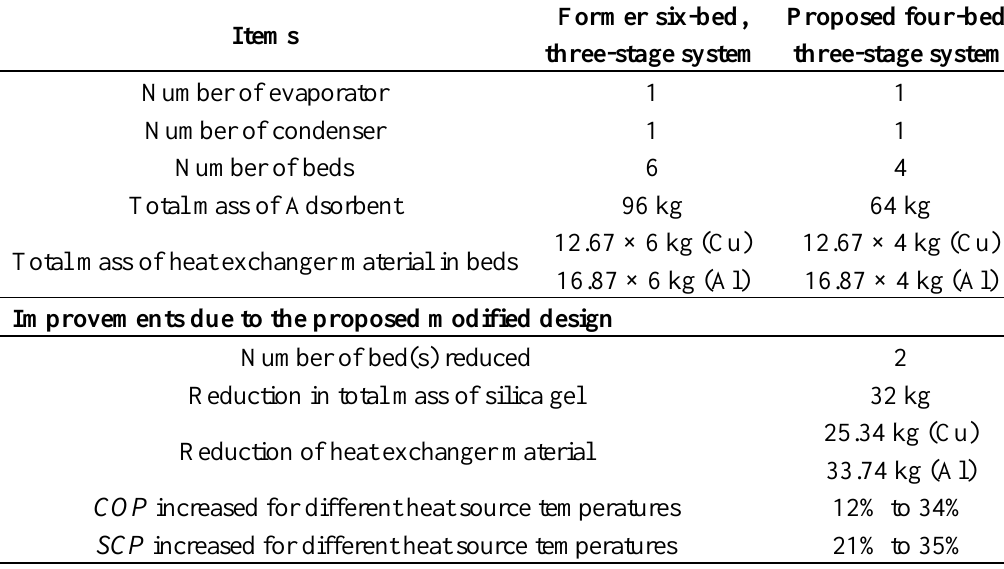
Table 3. Comparative study of former six-bed three-stage and proposed four-bed three-stage